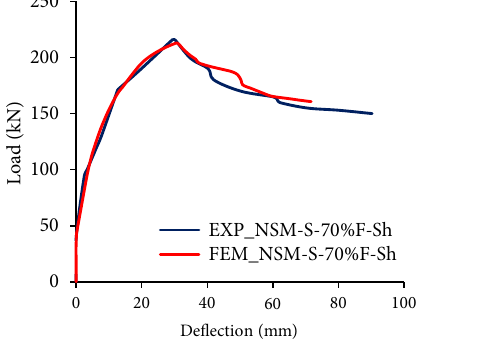
Figure 14. Load vs deflection curves of FEM and experimental beams